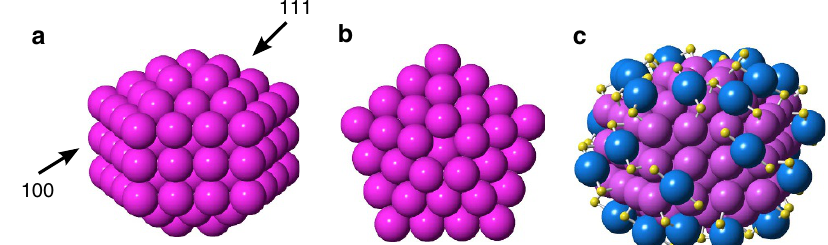
Figure 4 | 114-Atom and 144-atom ino decahedron cluster. ( a ) Side view. ( b ) Top view. ( c ) Decorated with 60 (SR-Au-SR) staples. Pink spheres show gold atoms in the cluster core, whereas blue spheres show gold in the staple structure. Sulfur is shown in yellow. The organic chains have been left out for